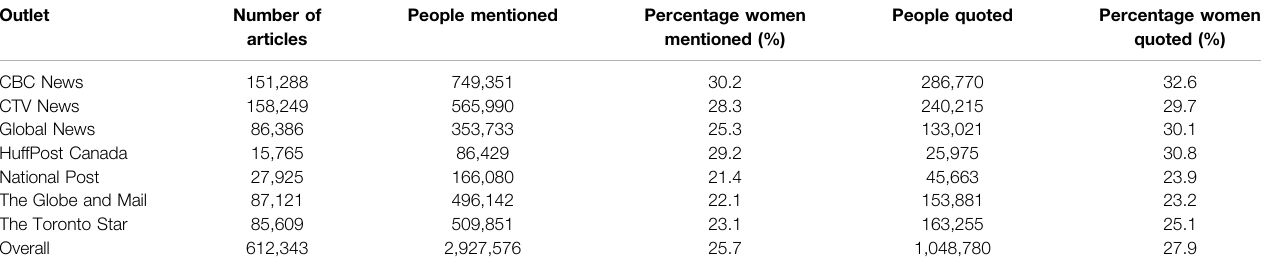
TABLE 1 | Data for the study, October 1, 2018 – September 30, 2020. Note: “ people mentioned ” is the number of all persons named in all the articles per outlet. “ People quoted ” is the number of mentioned persons who were quoted one or more times in each article. Each “ quote ” is only counted once per person per article. Outlet Number of articles